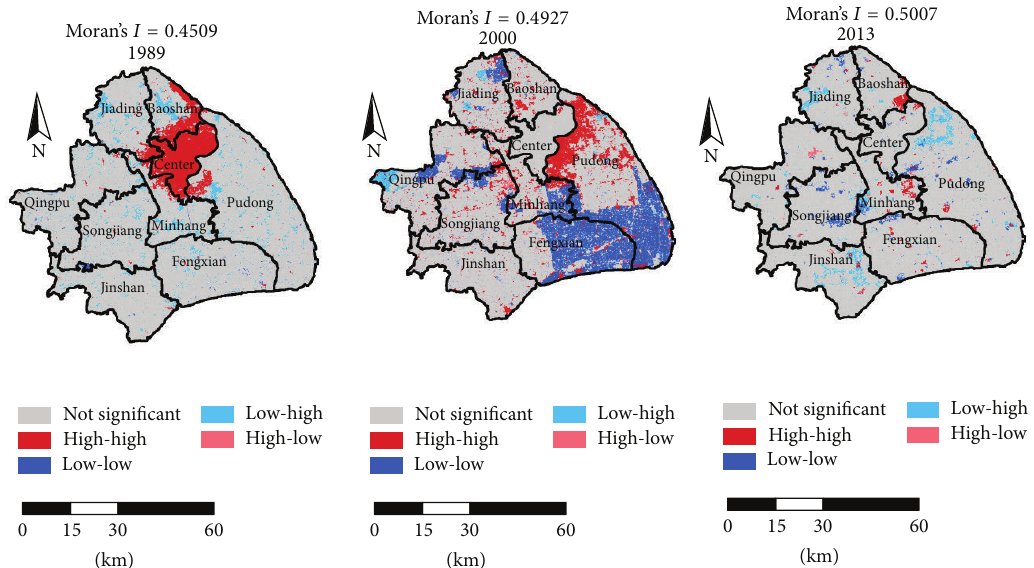
Figure 5: Spatial association of the thermal landscape pattern in Shanghai in 1989, 2000, and